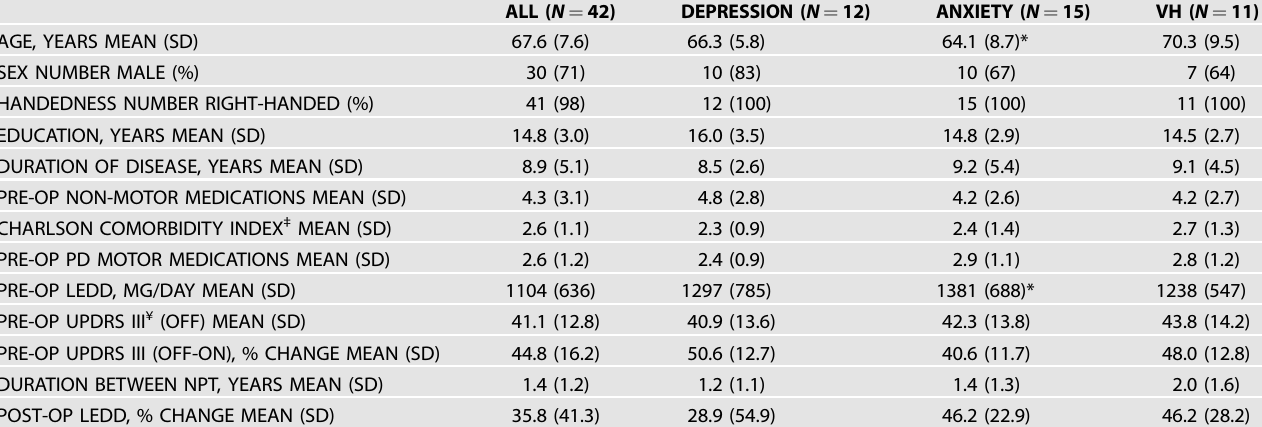
Table 1. Description of